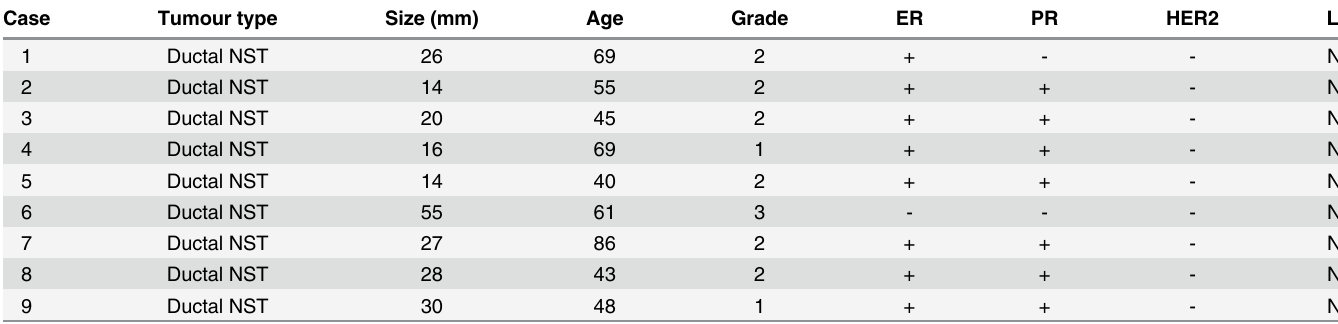
Table 1. Pathological features of patients selected for LMD of normal, DCIS and invasive breast lesions (n = 9).